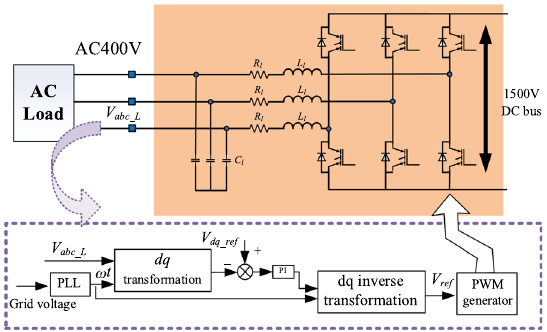
Fig. 4 DC/AC inverter control strategy